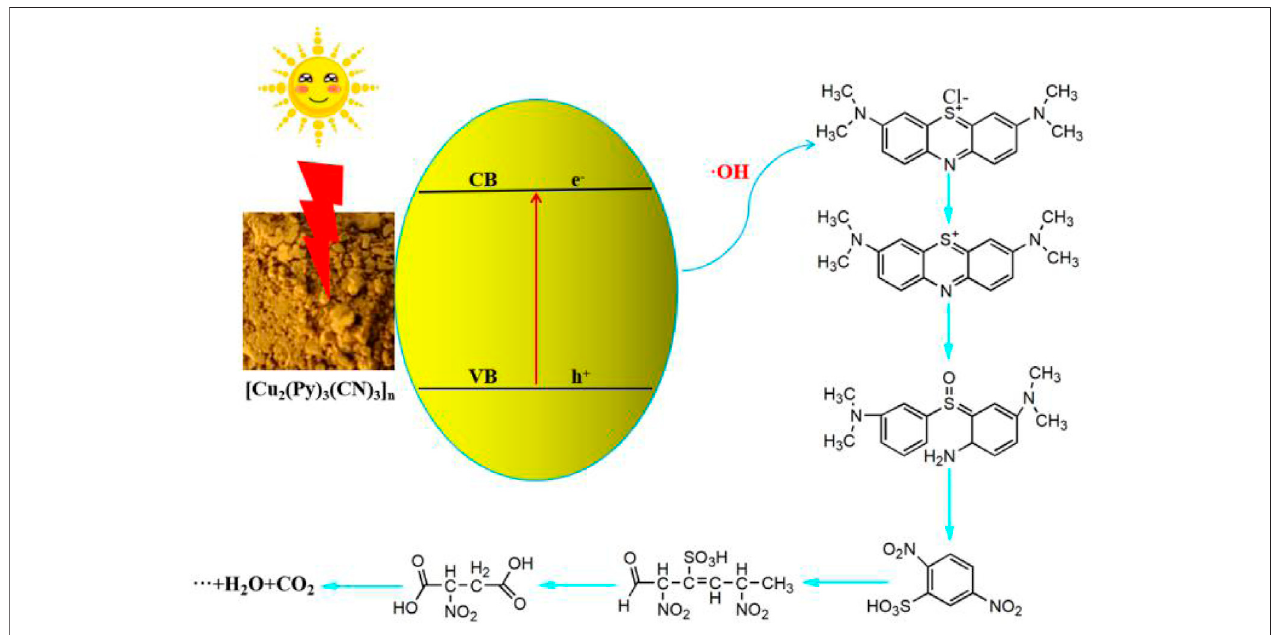
FIGURE 7 | Mechanism of photocatalytic degradation of MB by 1 .